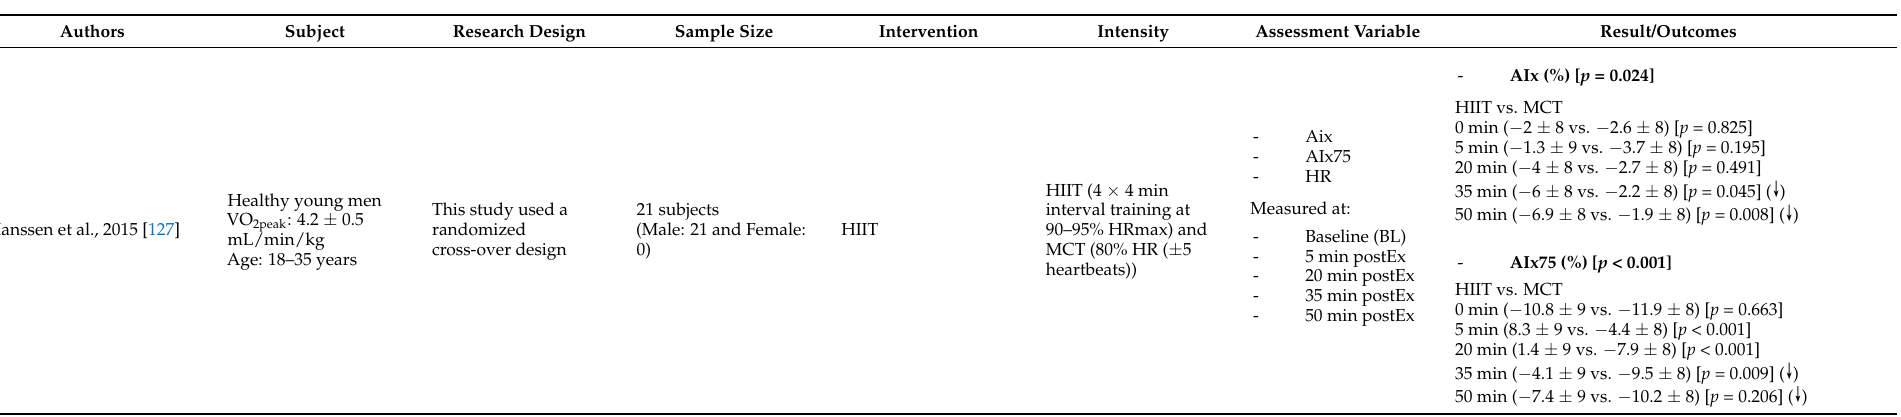
Table 2. Effect of aerobic exercise training on arterial stiffness. Table 4. Cont.